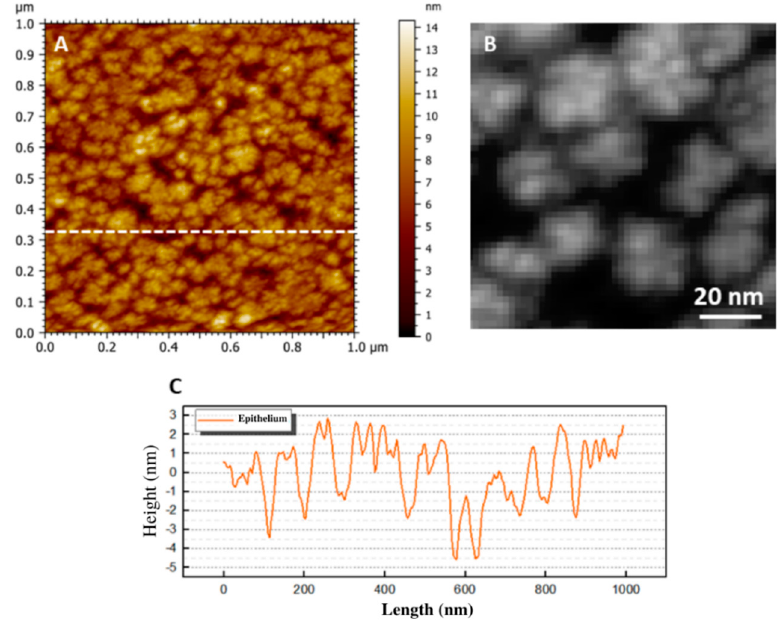
Figure 2. Topographic maps of the epithelial surface obtained using AFM. The 1 × 1 µm 2D images ( A ) show “microvilli”-like structures, with the epithelial cell membrane revealing various nanometer structures ( B ), indicating that these villi reached nanometer scales. A cross-section ( C ) in ( A ) shows nanovilli expressing the profile of peaks and valleys, with a diameter at the upper end of 9.8 ± 1.3 nm (in individual structures).